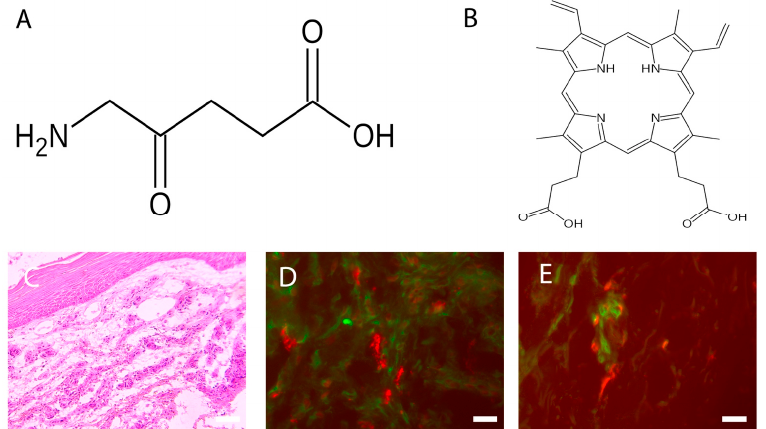
Figure 1. ( A ) Fvasconcellos (own work): Structural diagram of aminolevulinic acid. Created using ACD/ChemSketch 10.0 and Inkscape. This image of a simple structural formula is ineli- gible for copyright and, therefore, is in the public domain , because it contains no original au- thorship. ( B ) Fvasconcellos (own work): Skeletal formula of protoporphyrin IX. Created using